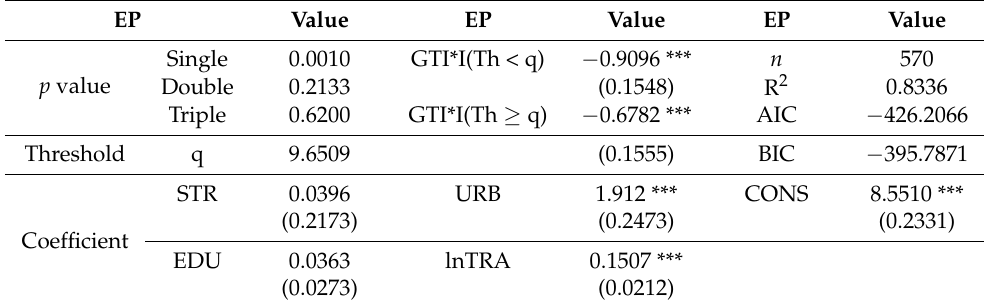
Table 7. Regression results of the panel threshold of GTI on